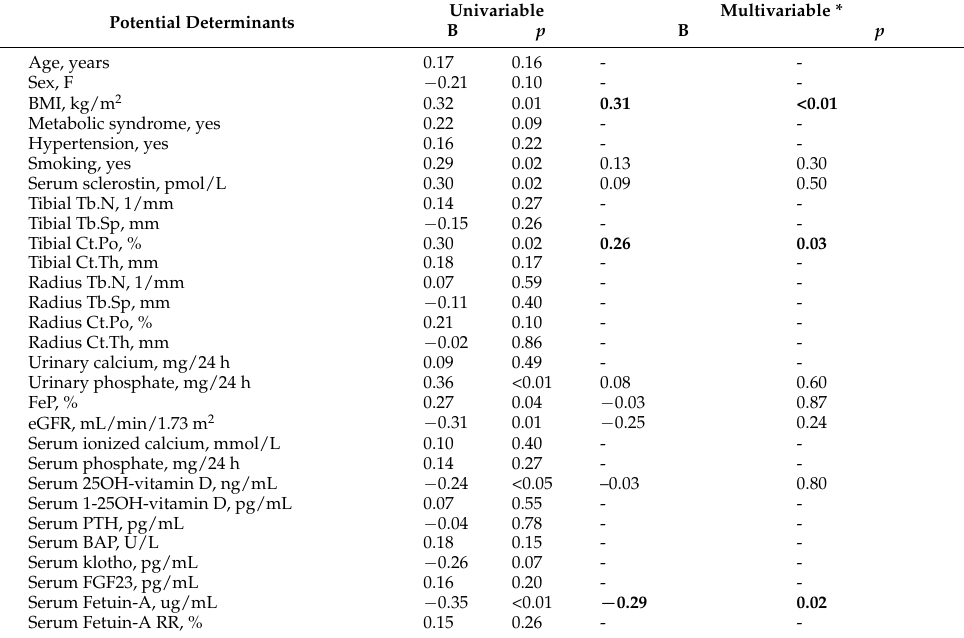
Table 3. Linear regression using AAC score as dependent